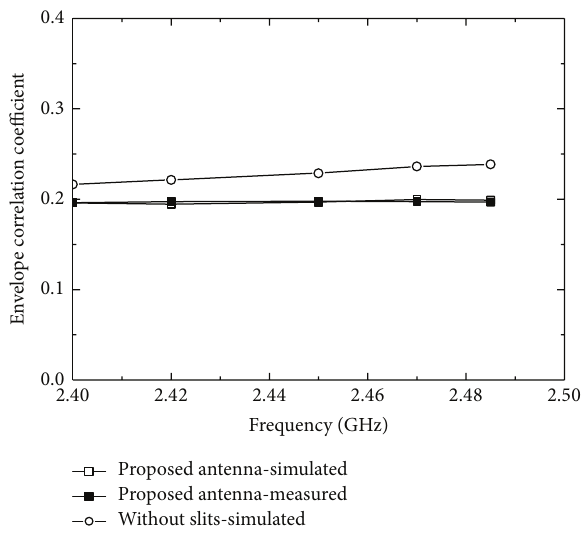
Figure 14: Simulated and measured envelope correlation coefficient of the proposed antenna and the antenna without